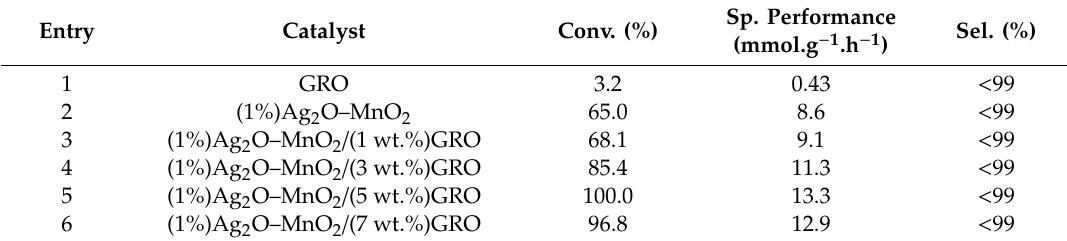
Table 2. Oxidation of BnOH using several wt.% of GRO.